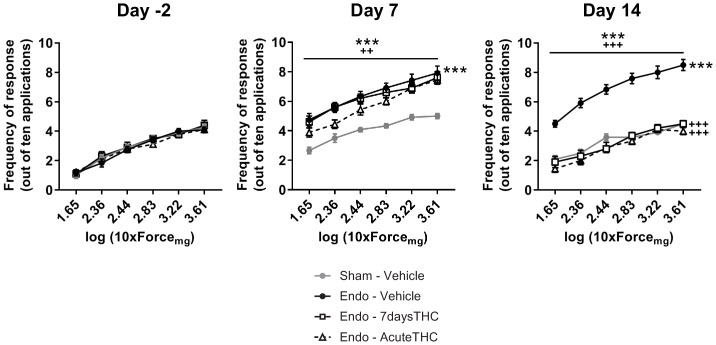
Effect of a repeated THC treatment starting on day 8 after surgeries on nociceptive responses to abdominal mechanical stimulation with von Frey filaments.Endometriosis mice treated with THC for 7 days (Endo – 7daysTHC) and endometriosis mice treated acutely with THC (Endo – AcuteTHC) showed a reduction in the frequency of response to von Frey filaments on day 14. THC dose: 2 mg/kg/day. Error bars are mean ± SEM. Mixed model + Bonferroni. ***p<0.001 vs sham; +++p<0.001 vs vehicle. Endo, endometriosis; THC, Δ9-tetrahydrocannabinol.